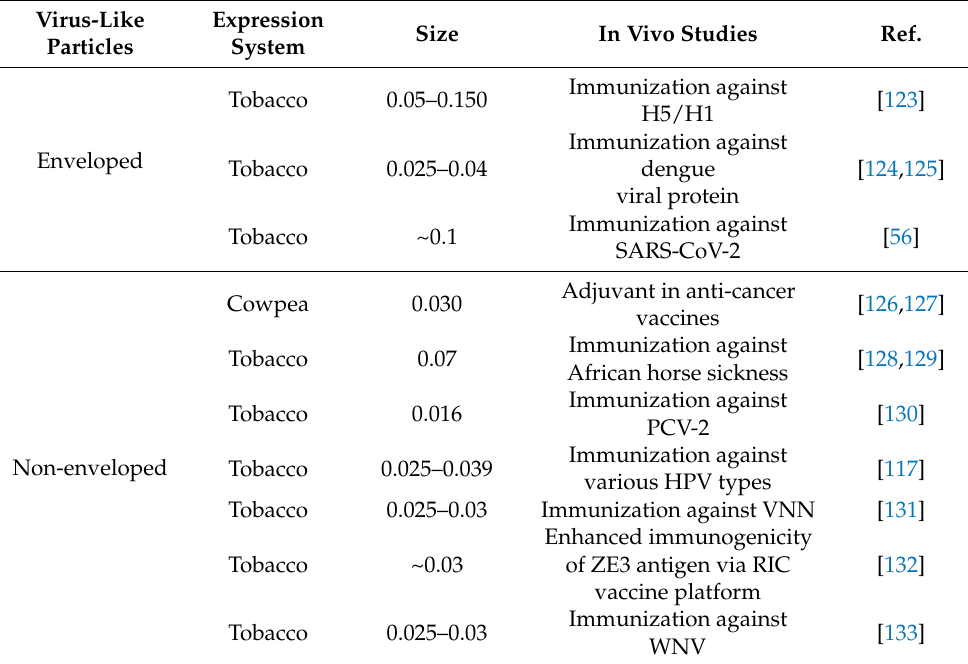
Table 2. Most recent examples of in planta produced virus-like particles (VLPs). Virus-Like Particles